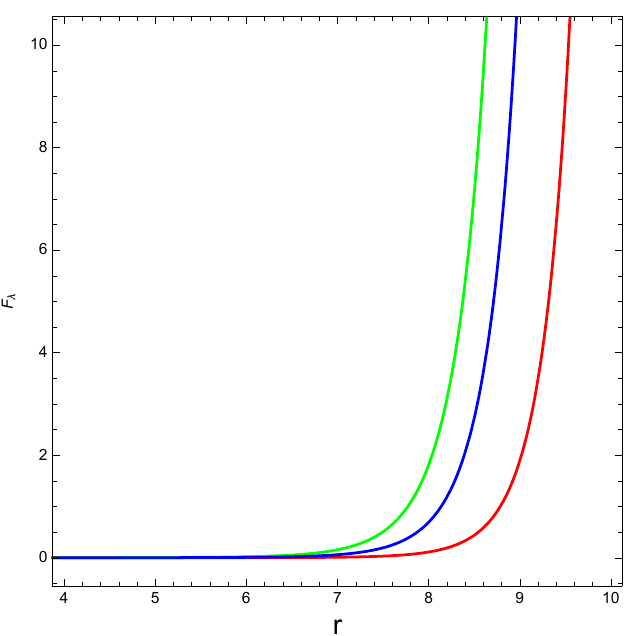
Figure 7. Solution of F ( R ( r )) for R adopted as quadratic function of radius. The evolution of the partial derivative of f ( R ) is obtained by Equations (7) and (33). We have fixed the values of η 2 , η 3 , a 0 , a 1 , a 2 , K , and C 1 . The red, green, and blue lines correspond to small perturbations of λ 0 , Ψ 0 , η 1 , respectively.